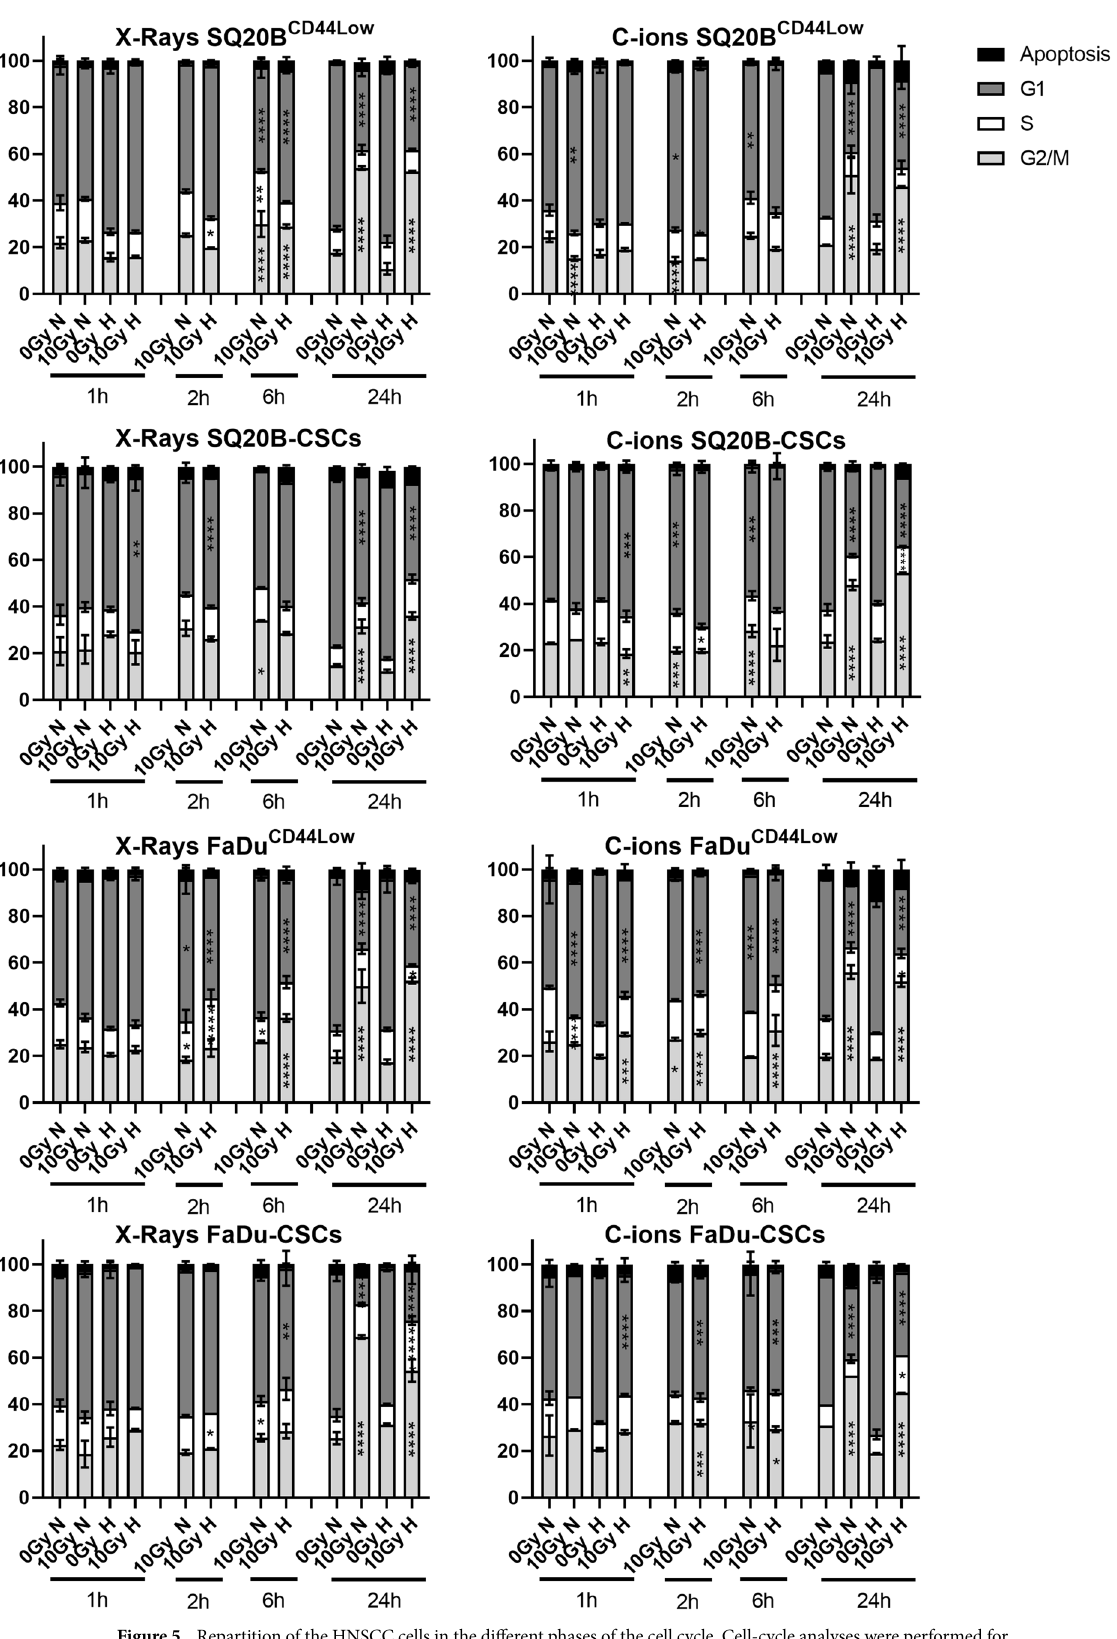
Figure 5. Repartition of the HNSCC cells in the different phases of the cell cycle. Cell-cycle analyses were performed for SQ20B CD44Low , SQ20B-CSCs FaDu CD44Low and FaDu-CSCs, in response to photons and C-ions in normoxic (N) and hypoxic conditions (H). Cells were grown under normoxia or hypoxia, irradiated with 10 Gy, and prepared for analysis by flow cytometry at 1, 2, 6, and 24 h after irradiation. The means and error bars (SD values) are presented and each condition was statistically compared to their respective non-irradiated condition (two-way ANOVA test). * P < 0.05, ** P < 0.01, *** P < 0.001, **** P < 0.0001 (n =